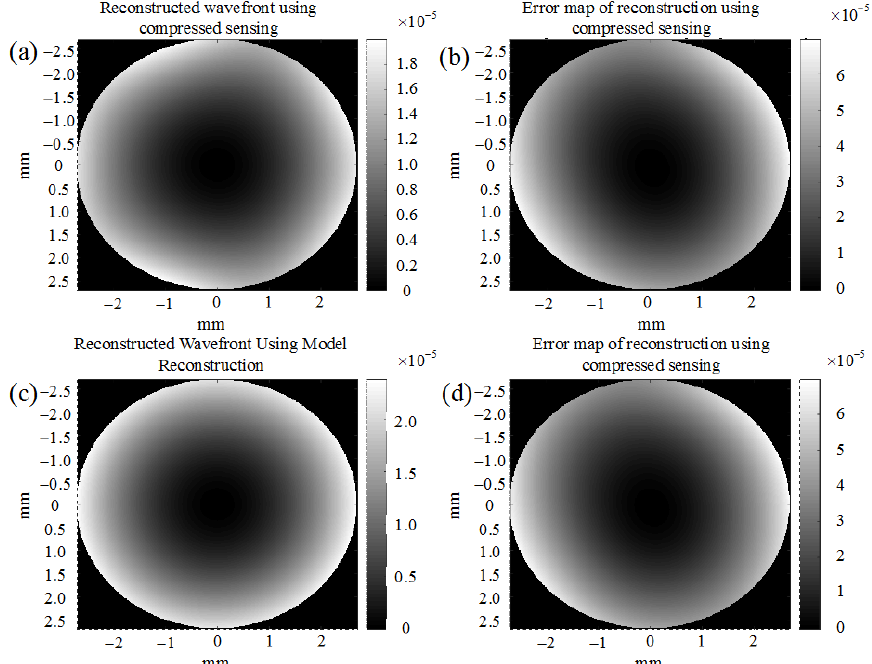
Fig. 8 Comparison of 100mm focal length bi-concave lens reconstruction: (a) reconstruction results, (b) error map using compressed wavefront sensing, (c) reconstruction results, and (d) error map using iterative modal wavefront reconstruction. Table 3 Performance of compressed wavefront sensing (CS) vs iterative modal wavefront reconstruction (LS) for different lenses. Focal Mean error CS Lens length ( μ